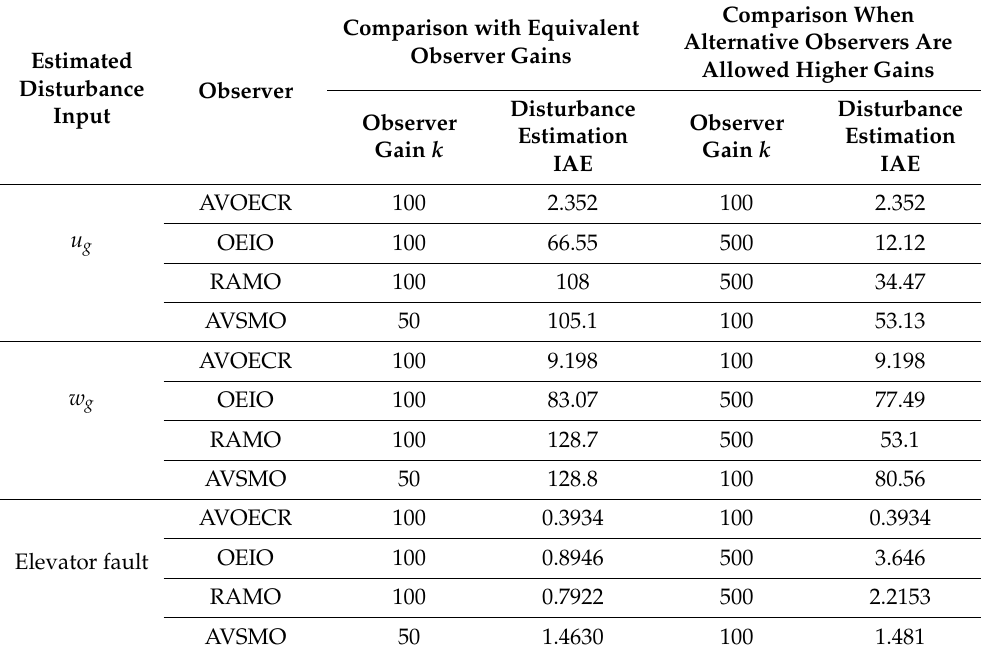
Table 3. Integrated absolute error for wind velocities and fault estimation using all observers. Comparison When Comparison with Equivalent Alternative Observers Are Observer Gains Estimated Allowed Higher Gains Disturbance Observer Disturbance Disturbance Input Observer Observer Estimation Gain k Gain k IAE